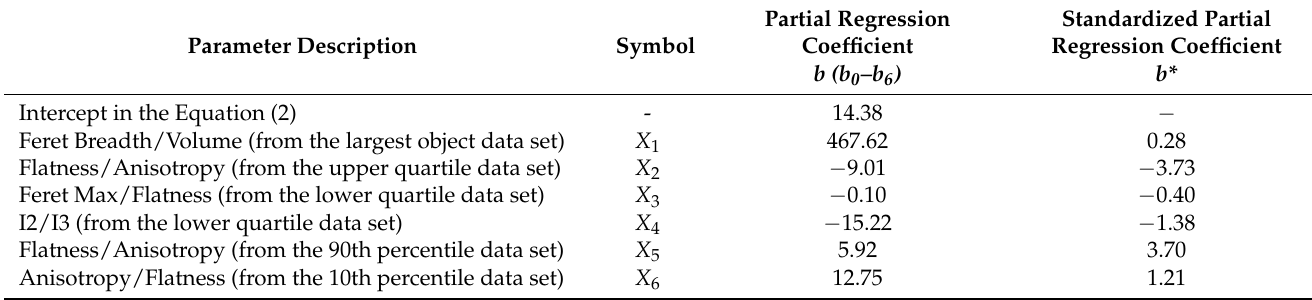
Table 4. Results of the best multiple linear regression analysis. Symbols: b* —standardized partial regression coefficient, b —partial regression